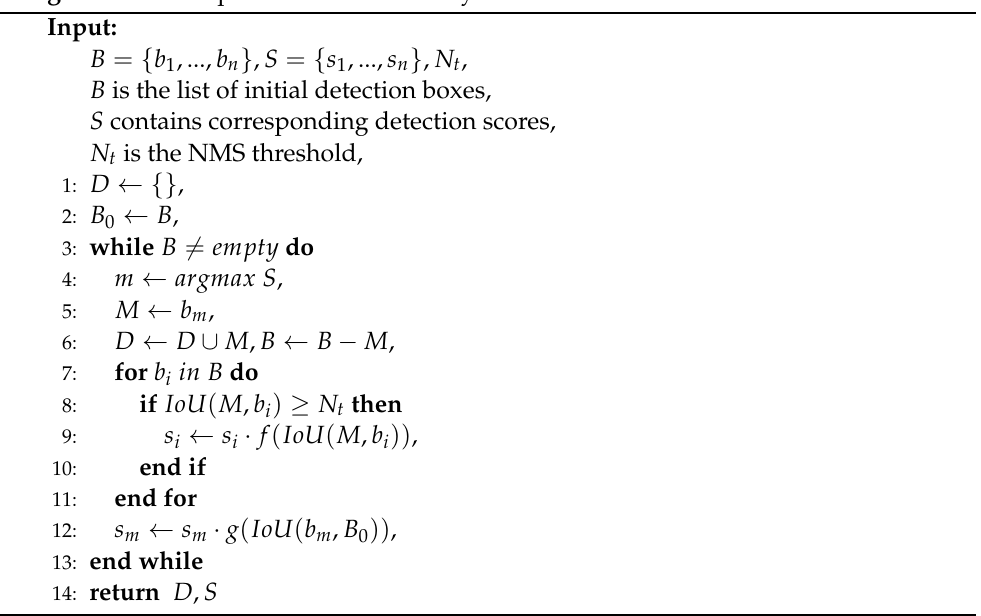
Algorithm 1: The pseudo-code of density-based